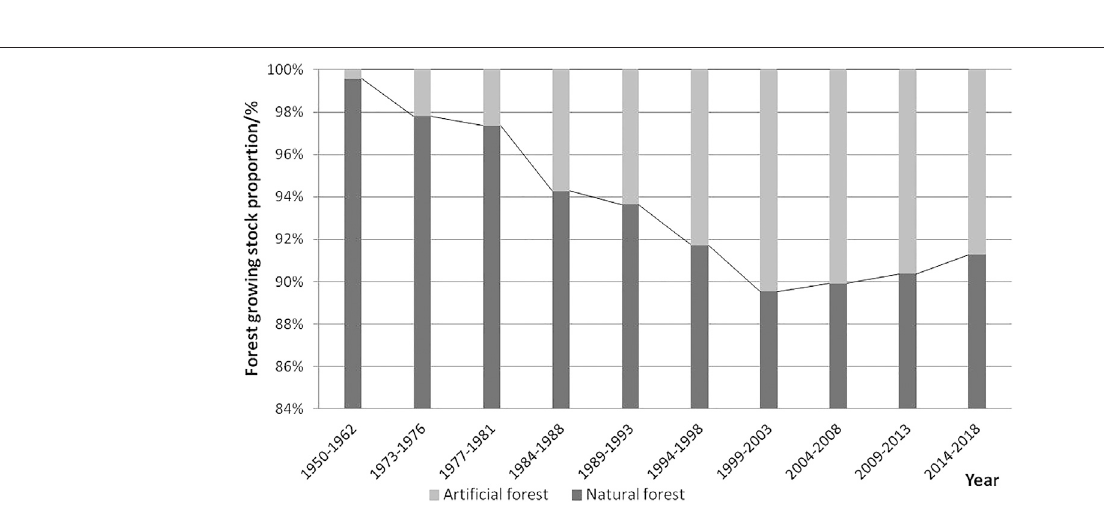
Frontiers in Environmental Science |